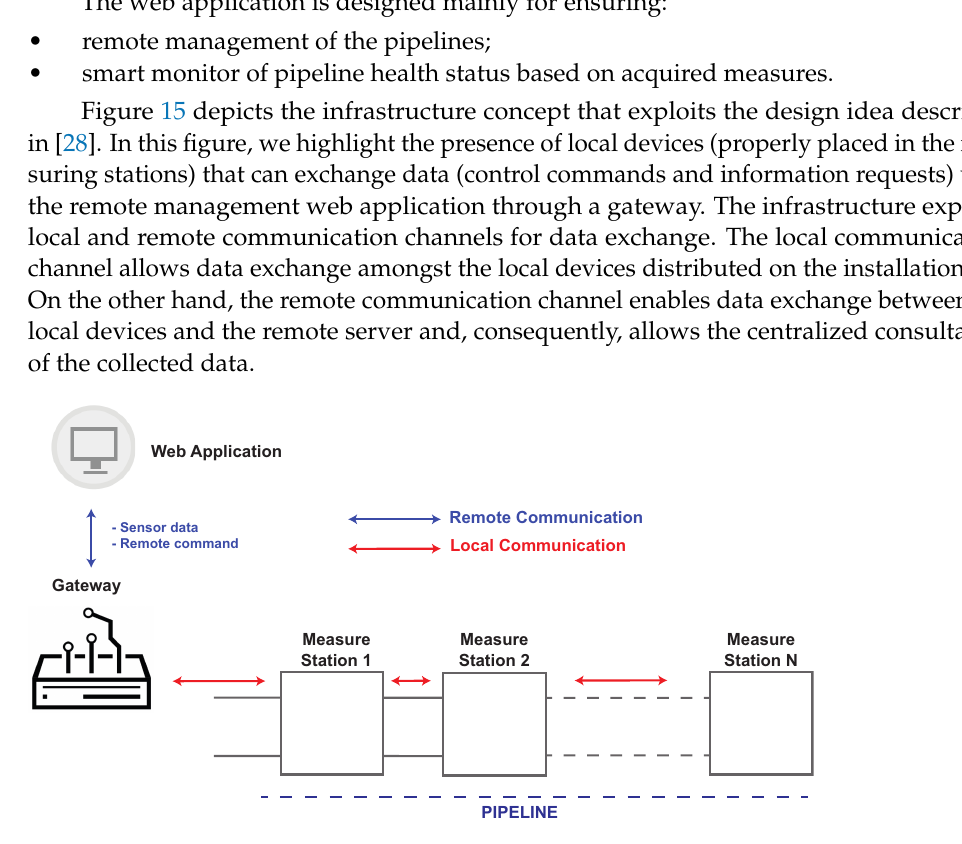
Figure 15. Smart pipeline